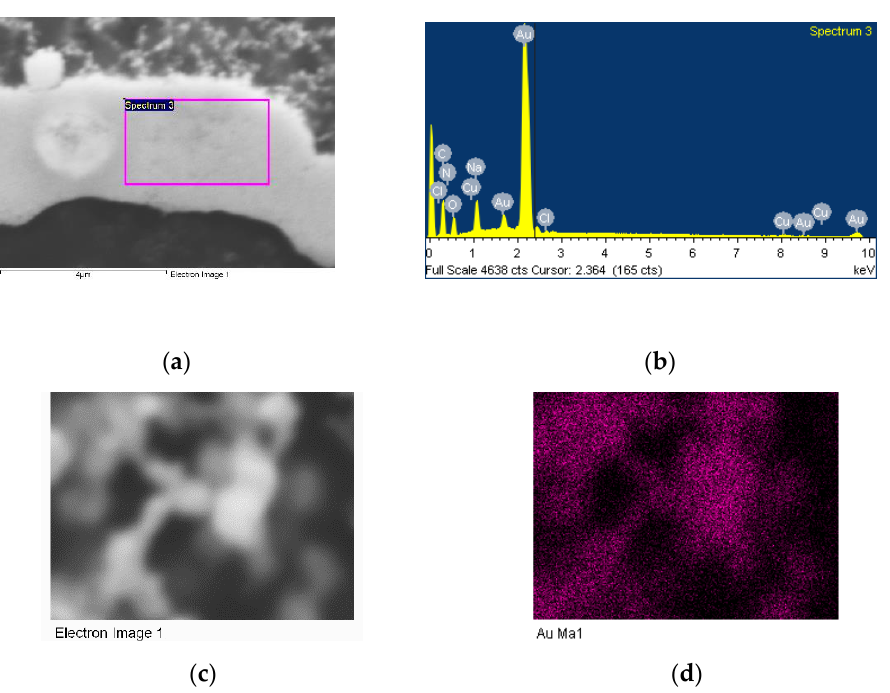
Figure 15. ( a ) SEM micrographs of erythrocyte membrane AuNPS-FI deposited on its surface, ( b ) EDS analysis onto cell membrane, ( c ) gold nanostructures attached to the erythrocyte, ( d ) EDS mapping of AuNPs.